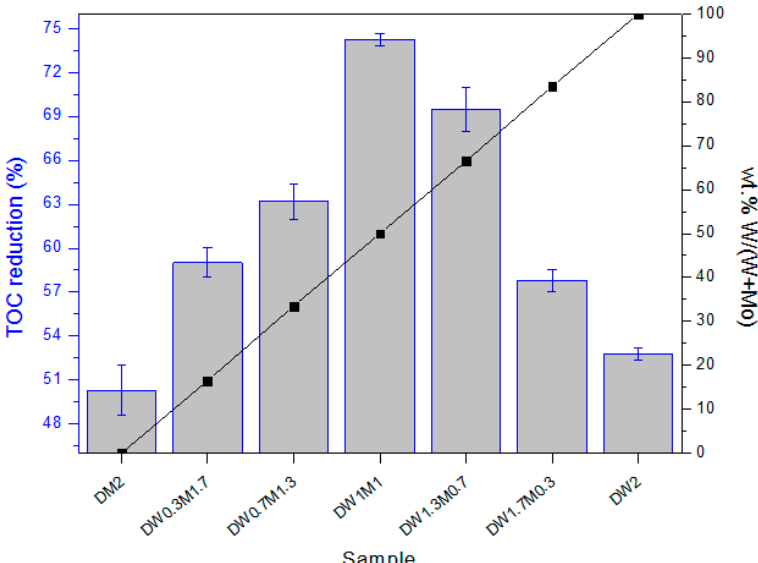
Figure 13. TOC reduction percentages and amount of tungsten dopant on mono-doped and co-doped